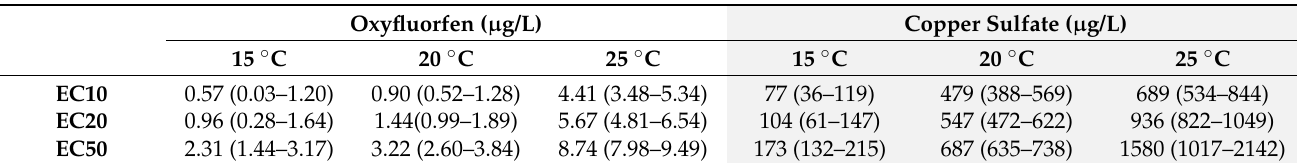
Table 1. EC values and confidence intervals (95%) for T. weissflogii when exposed to oxyfluorfen and to copper sulfate ( µ g/L) for 96 h, considering the growth rate